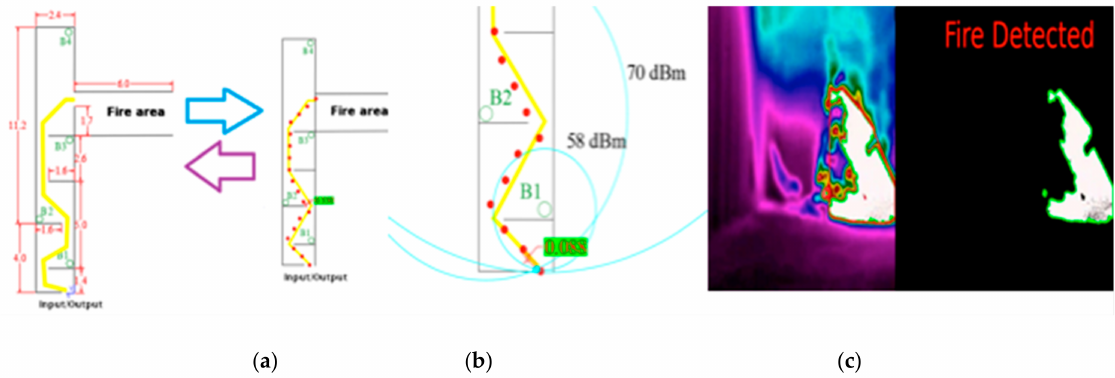
Figure 15. Map of Teresa with the real trajectory of the firefighter and the points detected by the IMU. ( a ) Result of the trajectory of the firefighter IMU+RSSI. ( b ) Correction of a point by the RSSI algorithm. ( c ) Result of the vision algorithm for fire detection obtained in the Teresa